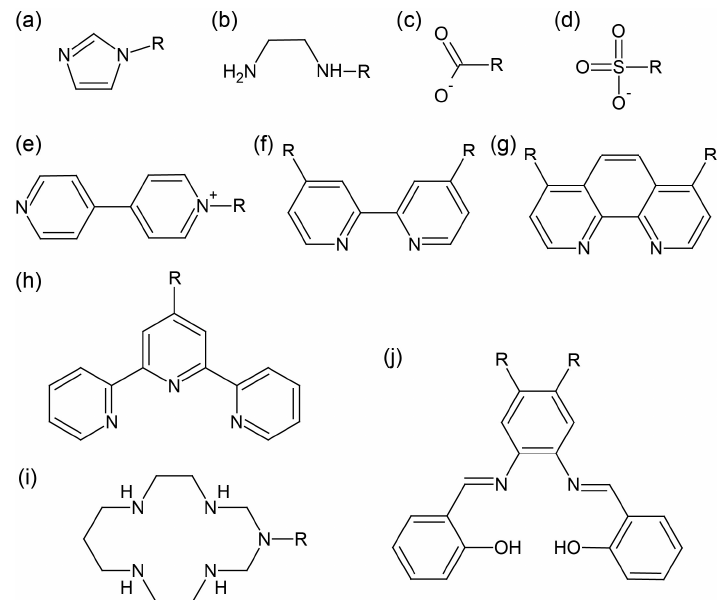
Figure 2. Structure of chlorophyll a 1